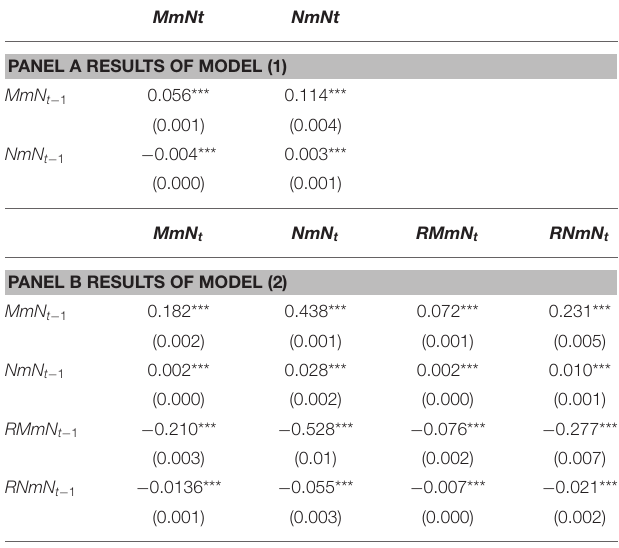
This table reports the results of the Panel Vector Autoregression (PVAR) Model for the four types of news. A 0 x t = f i + P 2 j = 1 A j x i , t − 1 + d i , t + µ i , t (model 1) and A 0 z t